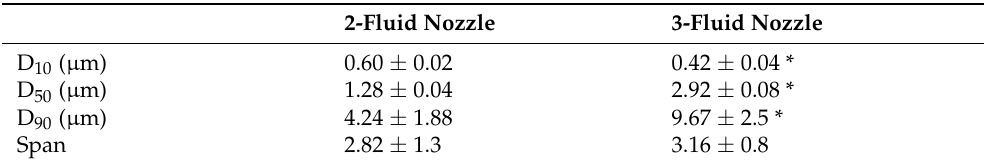
Table 2. Particle size and span range of 2FN and 3FN as measured by laser diffraction (Mean ± SD, n = 3, Unpaired Student’s t -test, * p < 0.01).